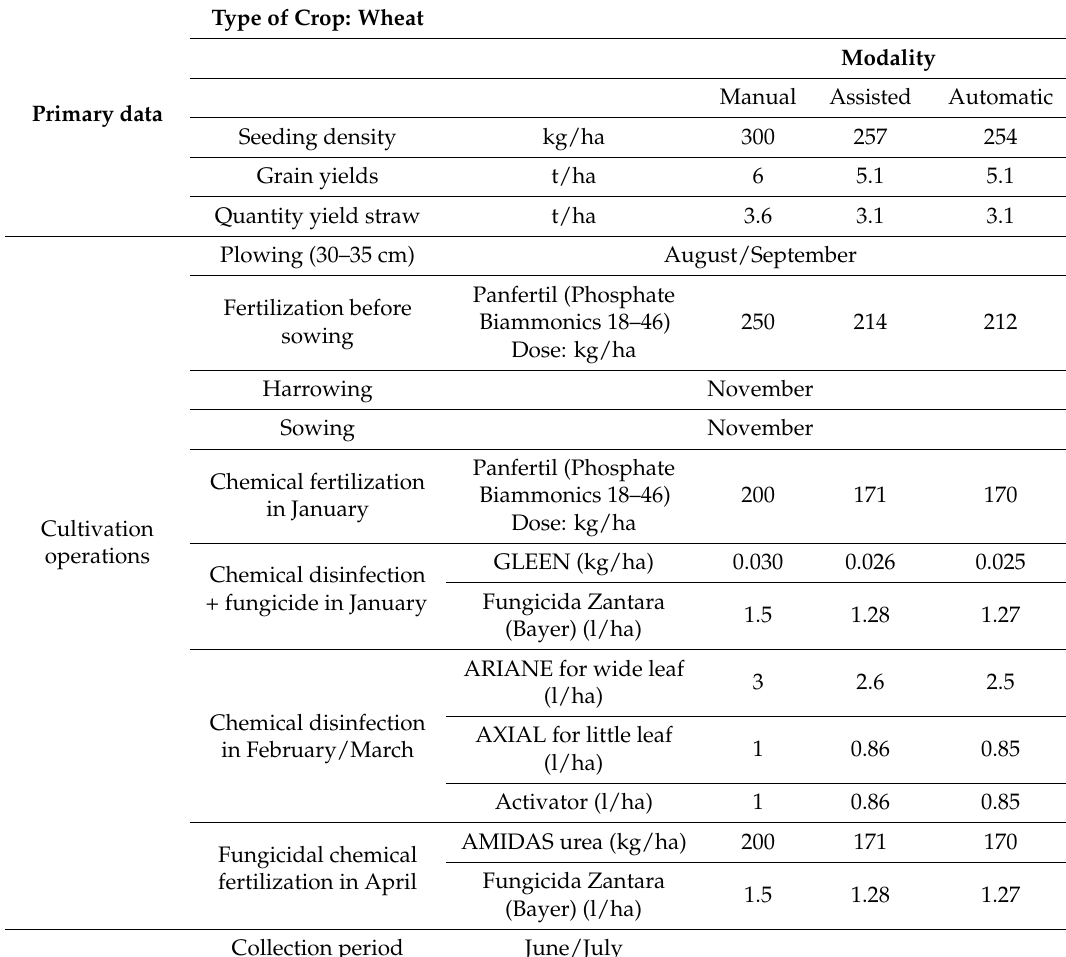
Table 1. Primary data collected during experimental field